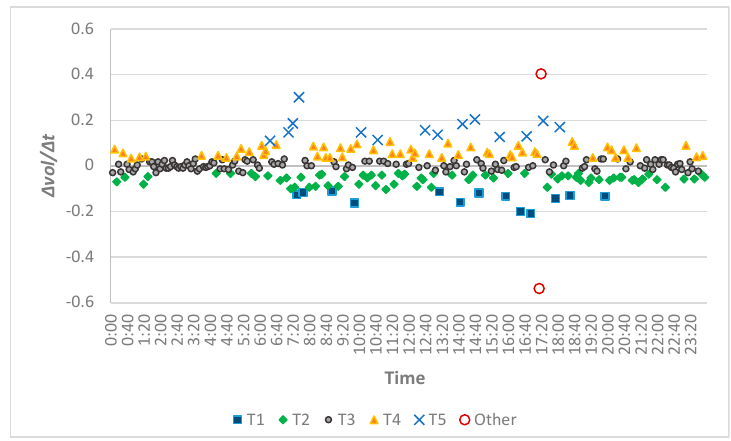
Figure 7. The five traffic types identified based on ∆ vol / ∆ t .